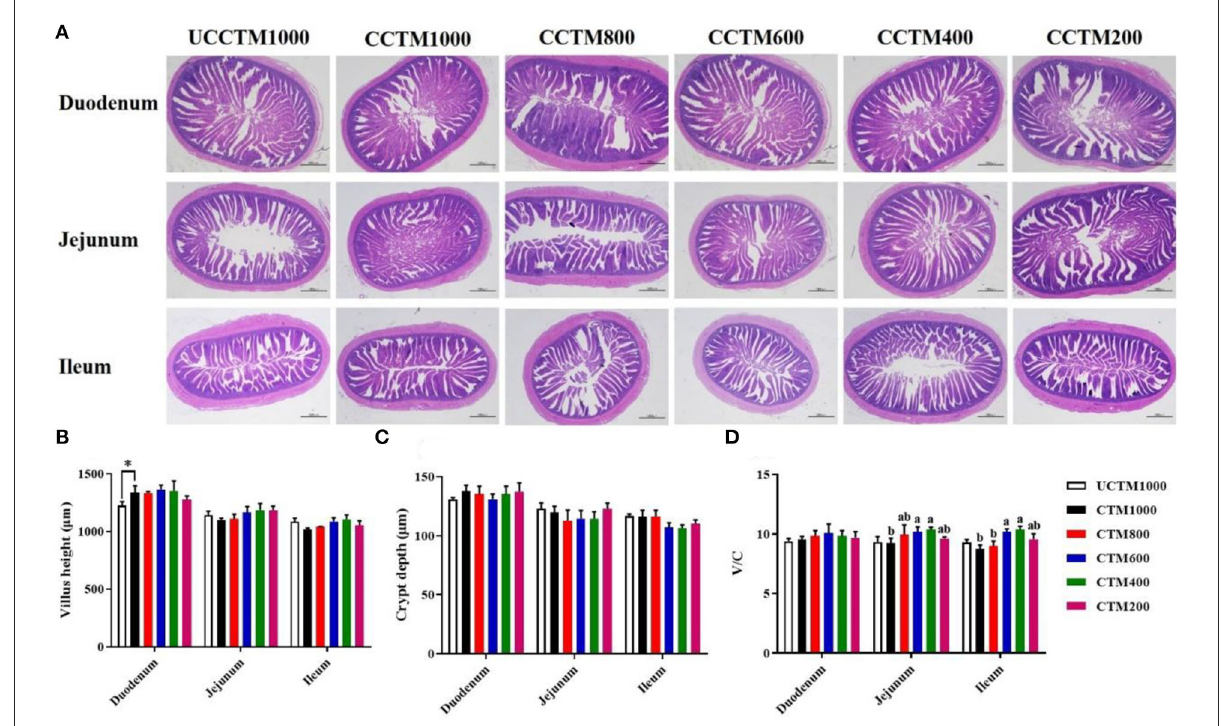
FIGURE3 Effects of dietary coated complex TMs on small intestinal morphology of yellow-feathered broilers. (A) Representative hematoxylin/eosin (H&E) staining was taken at a magnification of x 20 and (B) villus height, (C) cry depth, and (D) ratio of villus height (VH) to crypt depth (CD) were measured. Scale bar = 1,000 µ m. Results are mean value ± SE; n = 6 for each group. * P < 0.05 for the UCCTM1000 group vs. the CCTM1000 group. Mean values with different small letters denote significant differences among CCTM groups ( P < 0.05). UCCTM1000, supplemented with 1,000 mg/kg of uncoated complex trace minerals; CCTE1000, supplemented with 1,000 mg/kg of coated complex trace minerals; CCTE800, supplemented with 800 mg/kg of coated complex trace minerals; CCTE600, supplemented with 600 mg/kg of coated complex trace minerals; CCTE400, supplemented with 400 mg/kg of coated complex trace minerals; CCTE200, supplemented with 200 mg/kg of coated complex trace minerals.